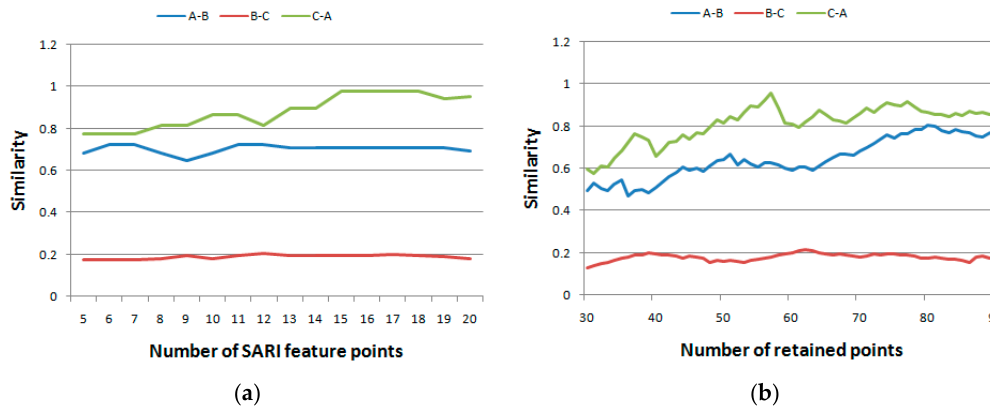
Figure 8. The impacts of parameters on the AVIRIS dataset. ( a ) Impact on the number of SRAI feature points and ( b ) on the number of retained points.